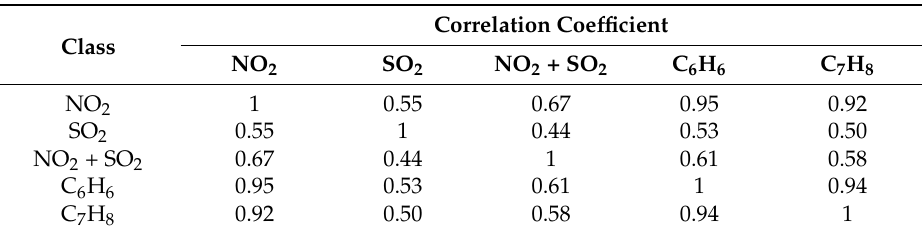
Table 2. Objective evaluation parameters of sensing